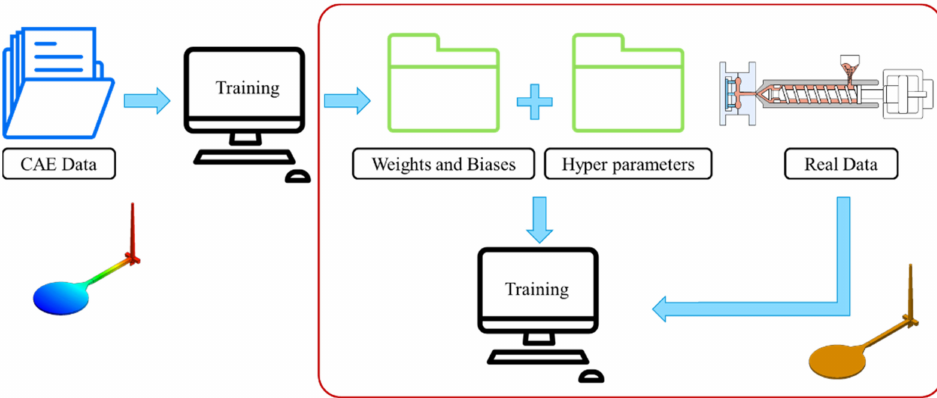
Figure 11. Flow chart of transfer learning from virtual to actual reality